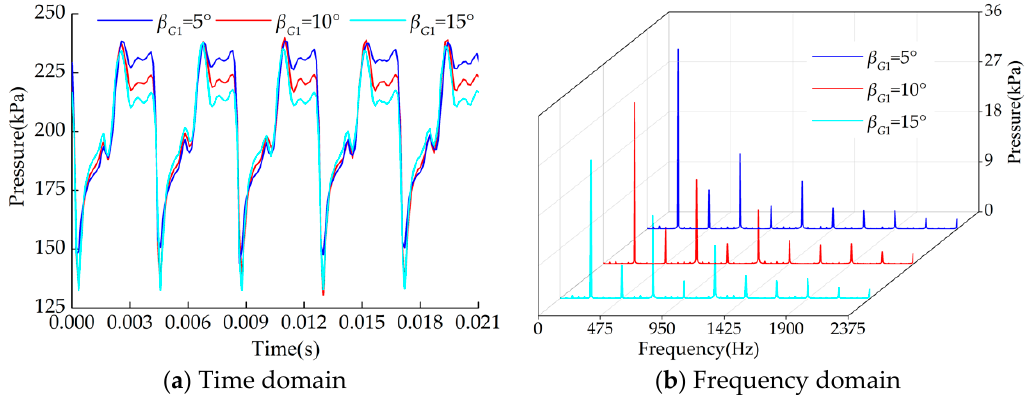
Figure 19. Time and frequency response curves of pressure inside the impeller with different inlet angles of the positive guide vane.